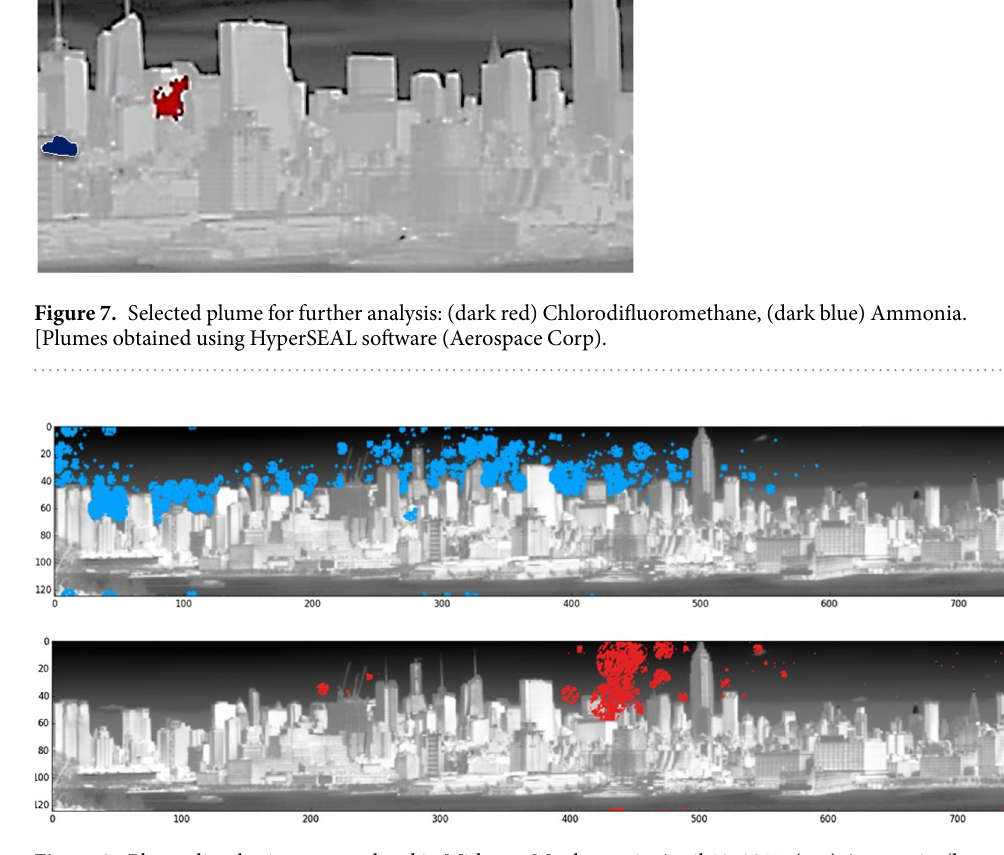
Figure 8. Plume distribution accumulated in Midtown Manhattan in April 12, 2015: (top) Ammonia, (bottom) Chlorodifluoromethane (Freon22). [Plume pixel ID by HyperSEAL software (Aerospace Corp). and by Python coding